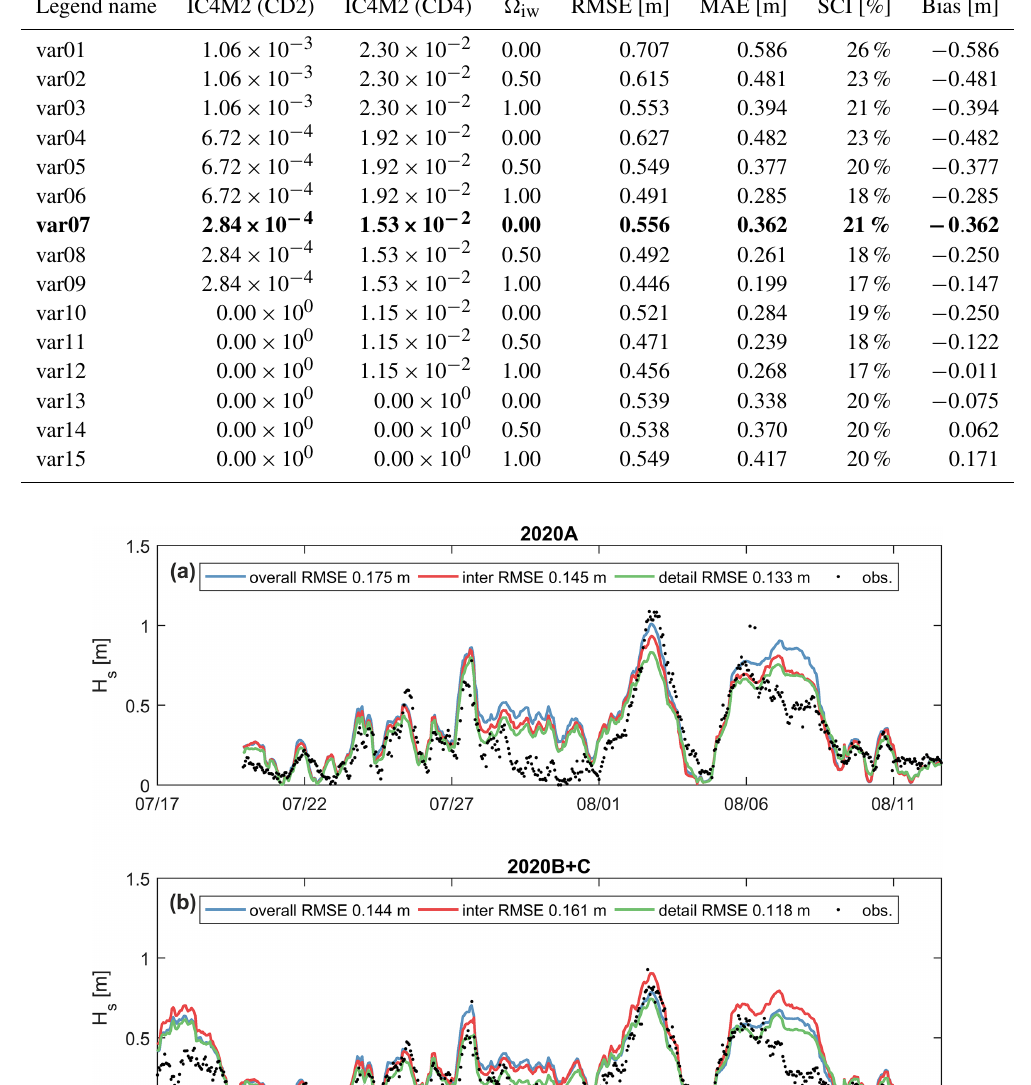
Table 3. Significant wave height model skill for different combinations of empirical ice coefficients describing dissipation and reduction in wave growth; var07 (bold) is the chosen value for the remainder of this study. All 1439 observations with at least a mean ice concentration of 5% from 2007–2013 are considered.